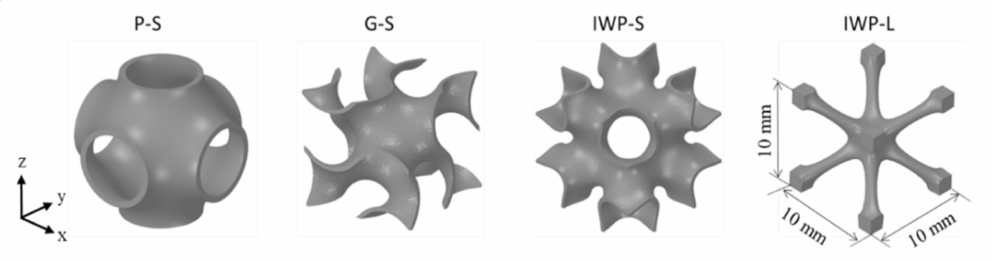
Figure 3. TPMS unit cell topologies pertaining to, e.g., relative density of ρ = 10, with unit cell dimensions of 10 mm × 10 mm × 10 mm.